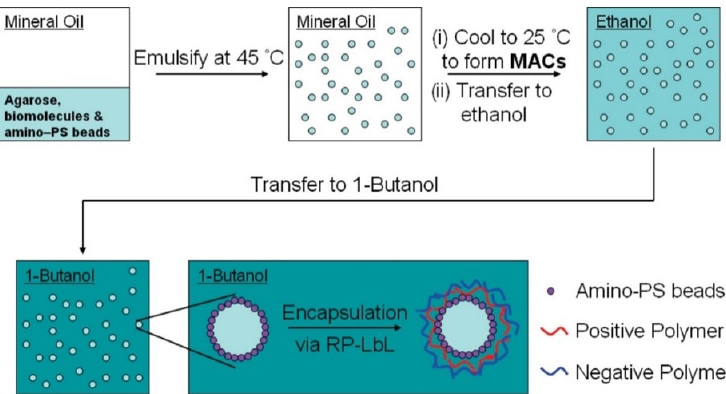
Figure 10. Sketch representing a general perspective of the encapsulation using the RP-LbL approach. Reprinted from Mak al. [179], Copyright (2009), with permission from American Chemical Society.